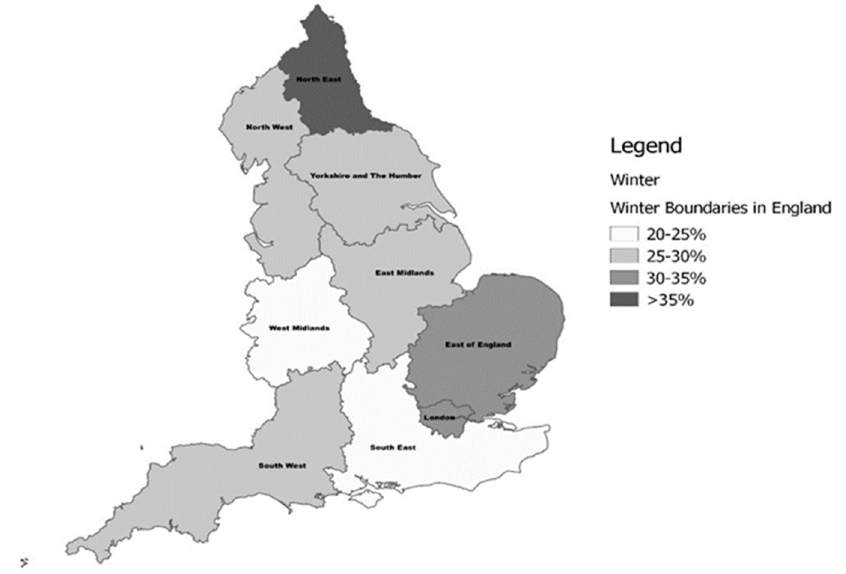
Figure 3. The prevalence of vitamin D deficiency (IOM <30 nmol/L) in English regions during the Winter period.